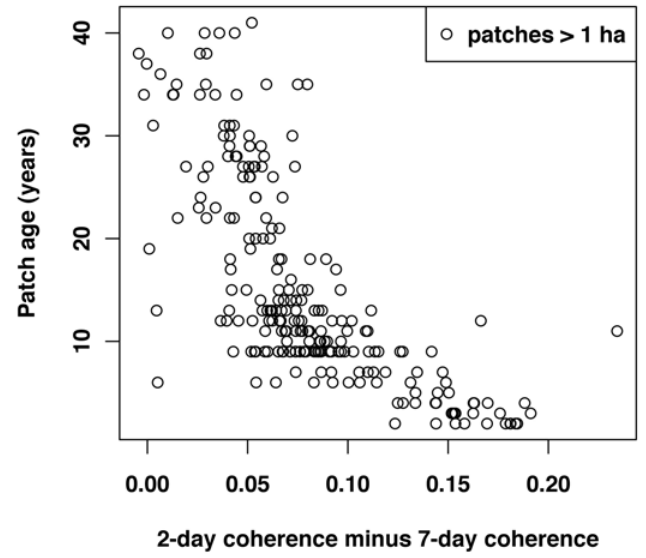
Figure 7. Differences in UAVSAR HH coherence between 2-day interval and 7-day temporal baselines. Note there is no temporal overlap between the two pairs (Table 2). The difference shows a marked decrease in coherence for young (<15 years) forest stands. This can explain the reduced model fit for the 7-day pair (Figure